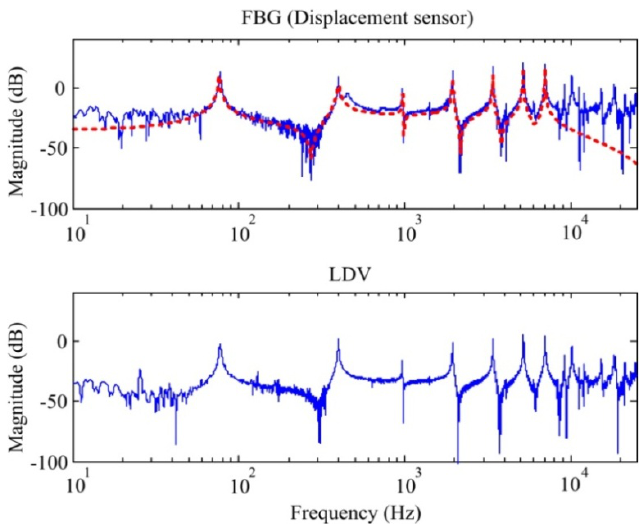
Figure 17. Frequency responses obtained by the FBG displacement sensor and LDV.